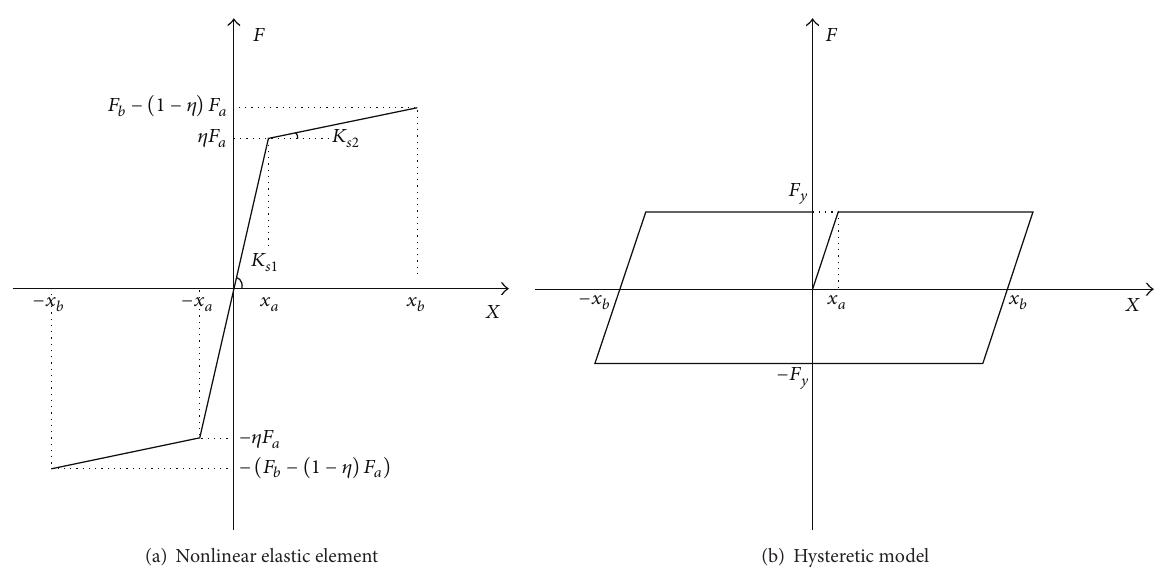
Figure 6: Schematic diagram of theoretical model of SMA